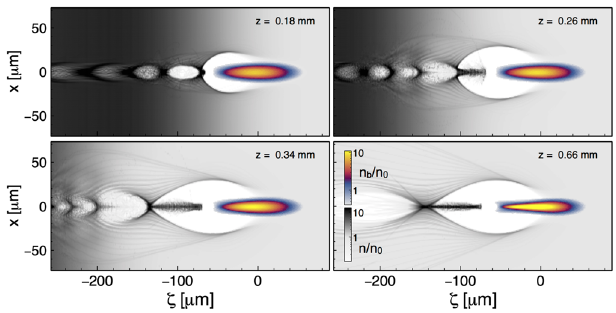
FIG. 6. Plasma and drive-beam densities along the density down-ramp region in a 3D PIC simulation (central horizontal ¼ 10 and ~ σ ¼ 2 . 5 in this case. slice of the simulation). ~ n l top